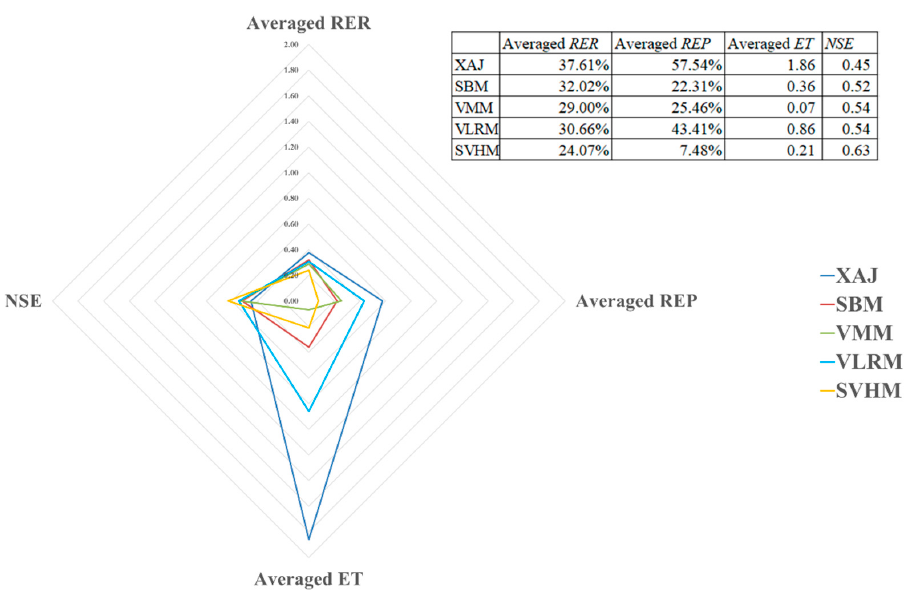
Figure 13. Comparisons of performance measures for different models in simulating all flood events in Chutoulang Basin (Note: REP denotes the relative error of flood peak, RER denotes the relative error of total runoff depth, ET denotes the error of peak appearance time and NSE denotes the Nash–Sutcliffe efficiency coefficient. REP, RER and NSE range from 0 to 1 and ET ranges from 0 to 2).